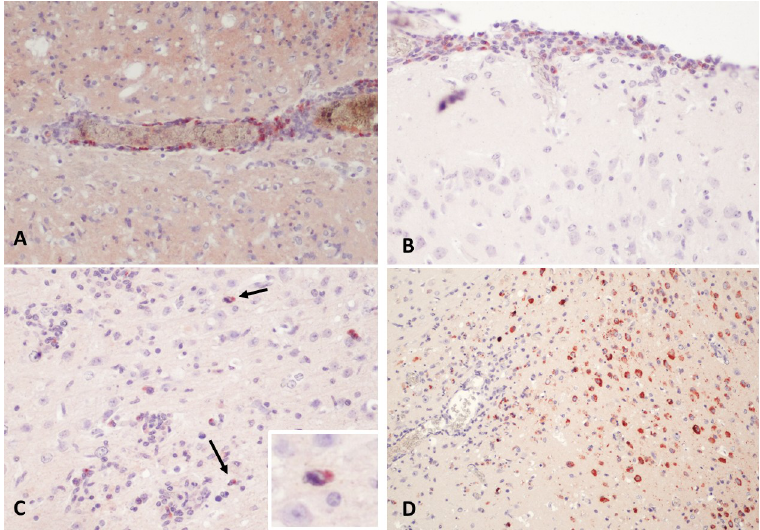
Fig 7. Immunohistochemistry of brain sections from mice injected with BgV-derived viruses. Virus positive cells appear with a red signal. A. Pericytes and leukocytes infiltrating in the Virchow’s space around cerebral blood vessels are positive for viral antigen in mouse culled on day 22 post-IC-inoculation of mutant chimera BgV T-AT /WNV-prME. B. Virus antigen positive cells amongst the leukocyte infiltrating the meninges in mouse culled on day 22 post-IC- inoculation with BgV T-AT /WNV-prME. C. Scattered neurons are positive for viral antigen, which is mainly located to the peri-nuclear Golgi-region (insert). Mouse culled on day 22 post-IC-inoculation of BgV T-AT /WNV-prME. D. Widespread cytoplasmic signal for viral antigen in brain of mouse IC-inoculated with WNV/BgV-prME and culled 8 days p.i..